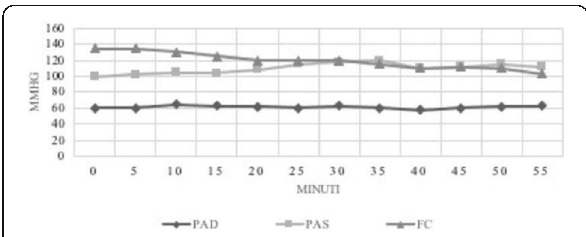
Fig. 2 (abstract A164). Perioperative hemodynamic